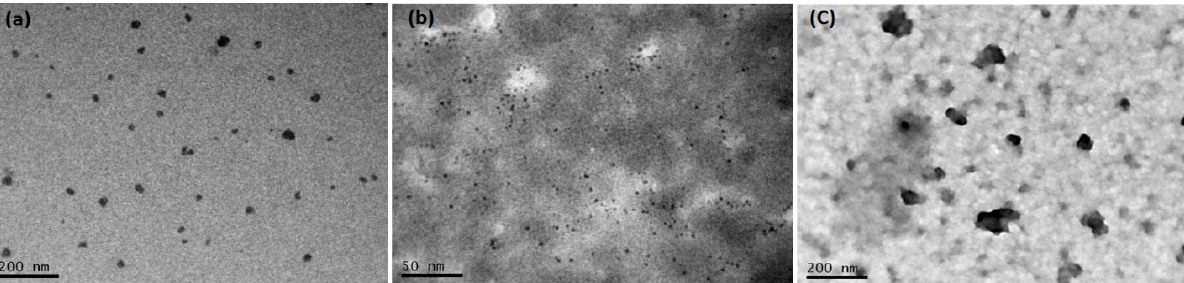
Figure 5. TEM images of (a) GT-nZVI, (b) PG-nZVI, (c) and (d) GA-nZVI.